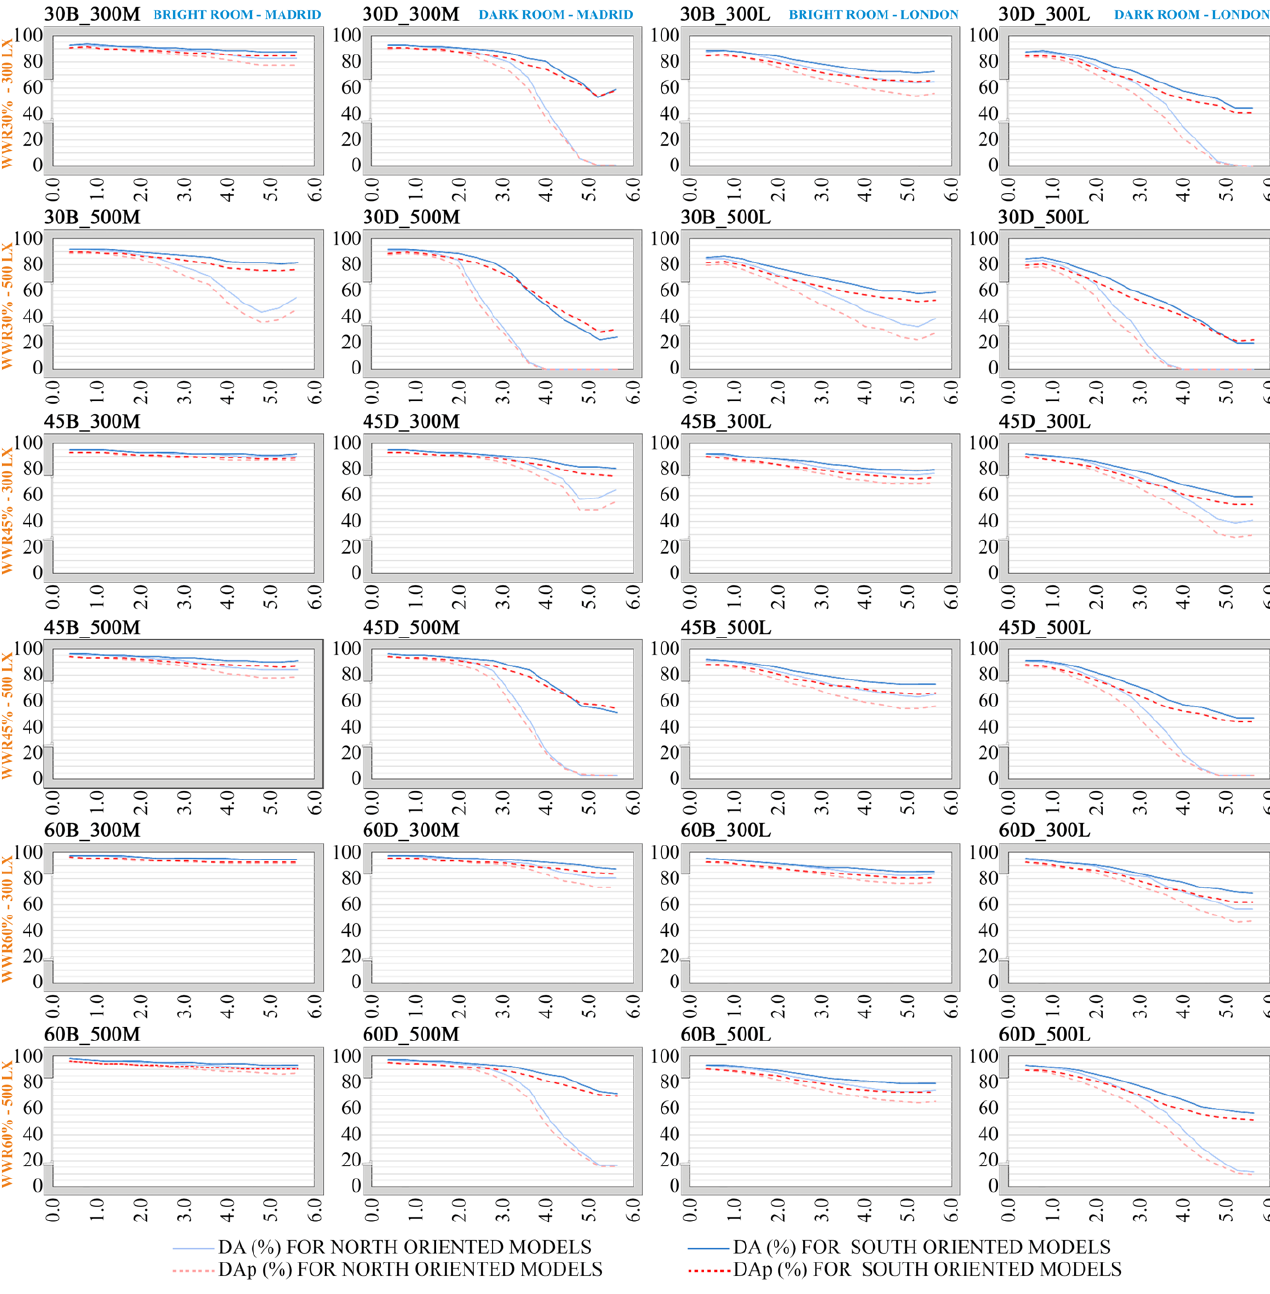
Figure 5. Quantification of DA and DAp in the calculation models according to window orientation.